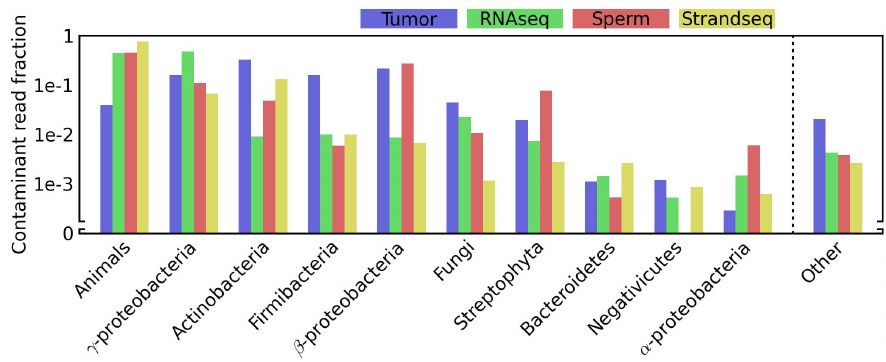
Figure 2. Reads that do not map to the reference genome match a diverse array of clades. For each experiment (‘‘Tumor’’ [23], ‘‘RNAseq’’ [25], ‘‘Sperm’’ [26], and ‘‘Strandseq’’ [24]), all reads were individually mapped to the appropriate reference genome using permissive parameters before being used to query the NR database using BLAST. BLAST hits were considered ‘‘perfect’’ if they matched with 100% identity over a dataset- specific length threshold (see Methods). A read was assigned to one of the depicted phylogenetic categories if it did not map or have a perfect BLAST hit to the reference genome, had a perfect BLAST hit to a species in that category, and had no BLAST hits to species outside that category. For each category and experiment, the fraction of reads meeting this criteria against the total number of reads in the experiment is depicted.